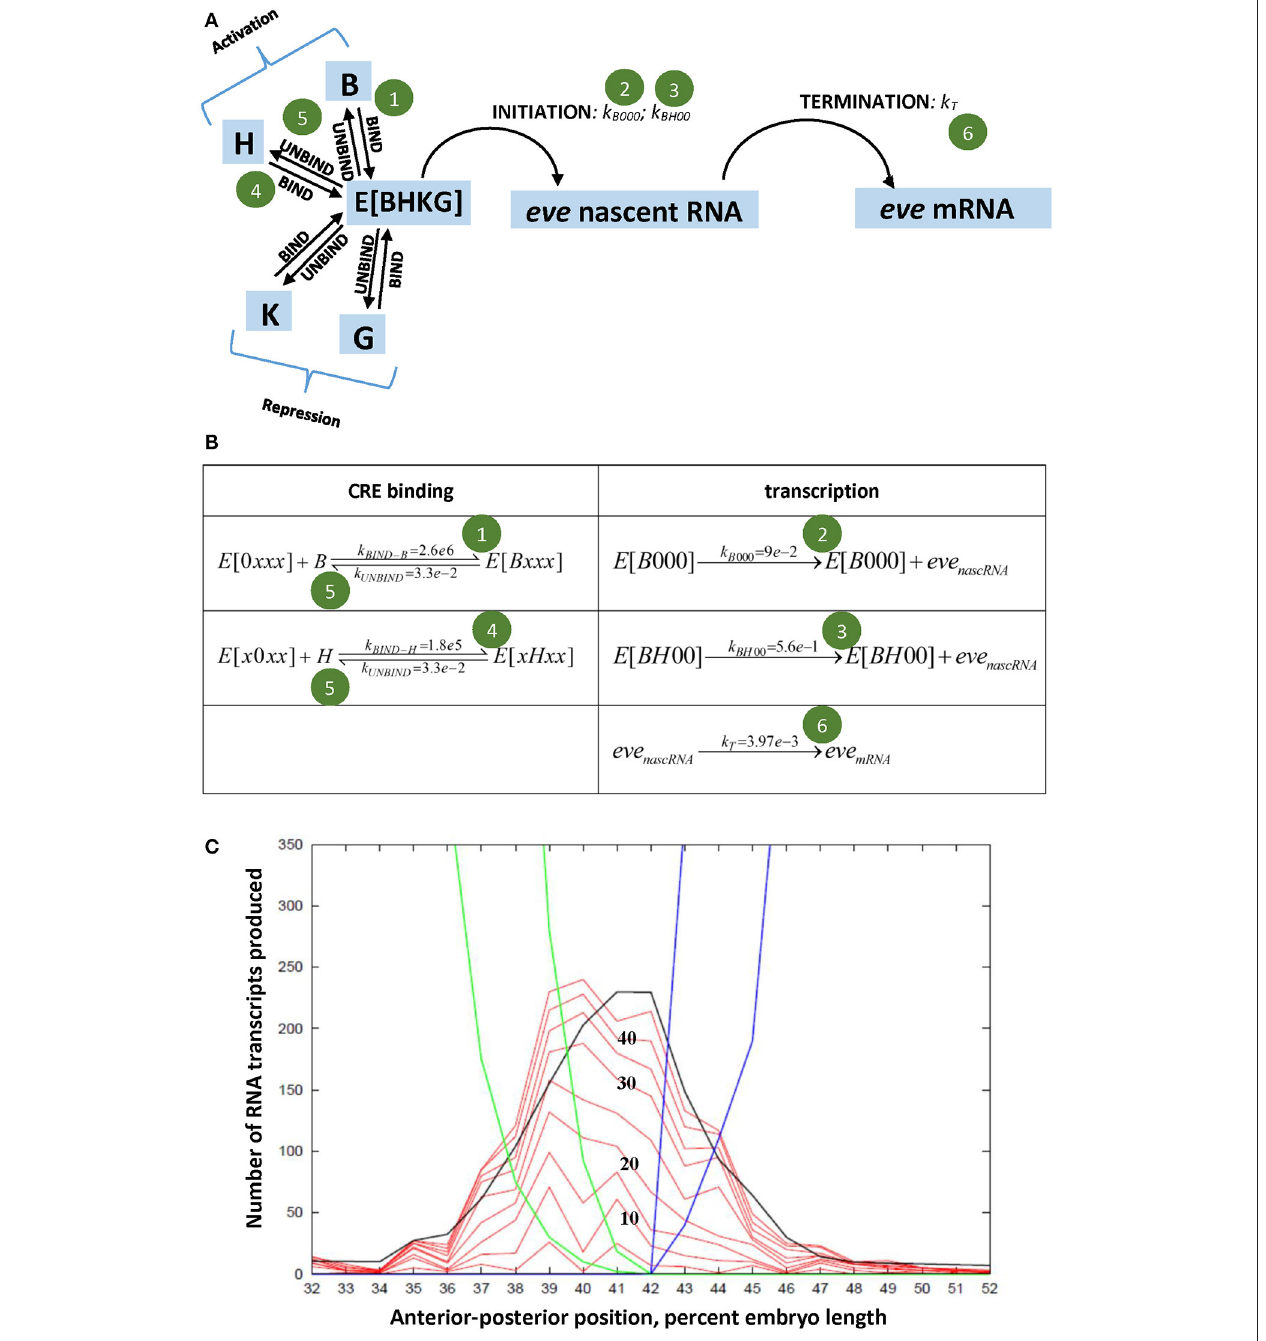
FIGURE 2 | (A) States (blue) and events (arrows) of the stochastic eve2 transcription model [66]; shown as elementary reactions in (B) , solved as master equations [80, 81]. E, the eve2 MSE, can bind four transcription factors (B, Bcd; H, Hb; K, Kr; G, Gt); transcriptional initiation occurs at a LOW (green circle 2) or HIGH (circle 3) rate. Experimental signal corresponds to eve nascent RNA. K, G repression not shown in (B) , see [66]. (C) Modeled spatial patterning of eve2 : numbers of transcripts against position. Red, stochastic solutions at 5min intervals (times numbered in black); black line, deterministic solution at 45min; blue (Kr) and green (Gt), early (outer) and late (inner) repressor patterns. Adapted from Holloway and Spirov